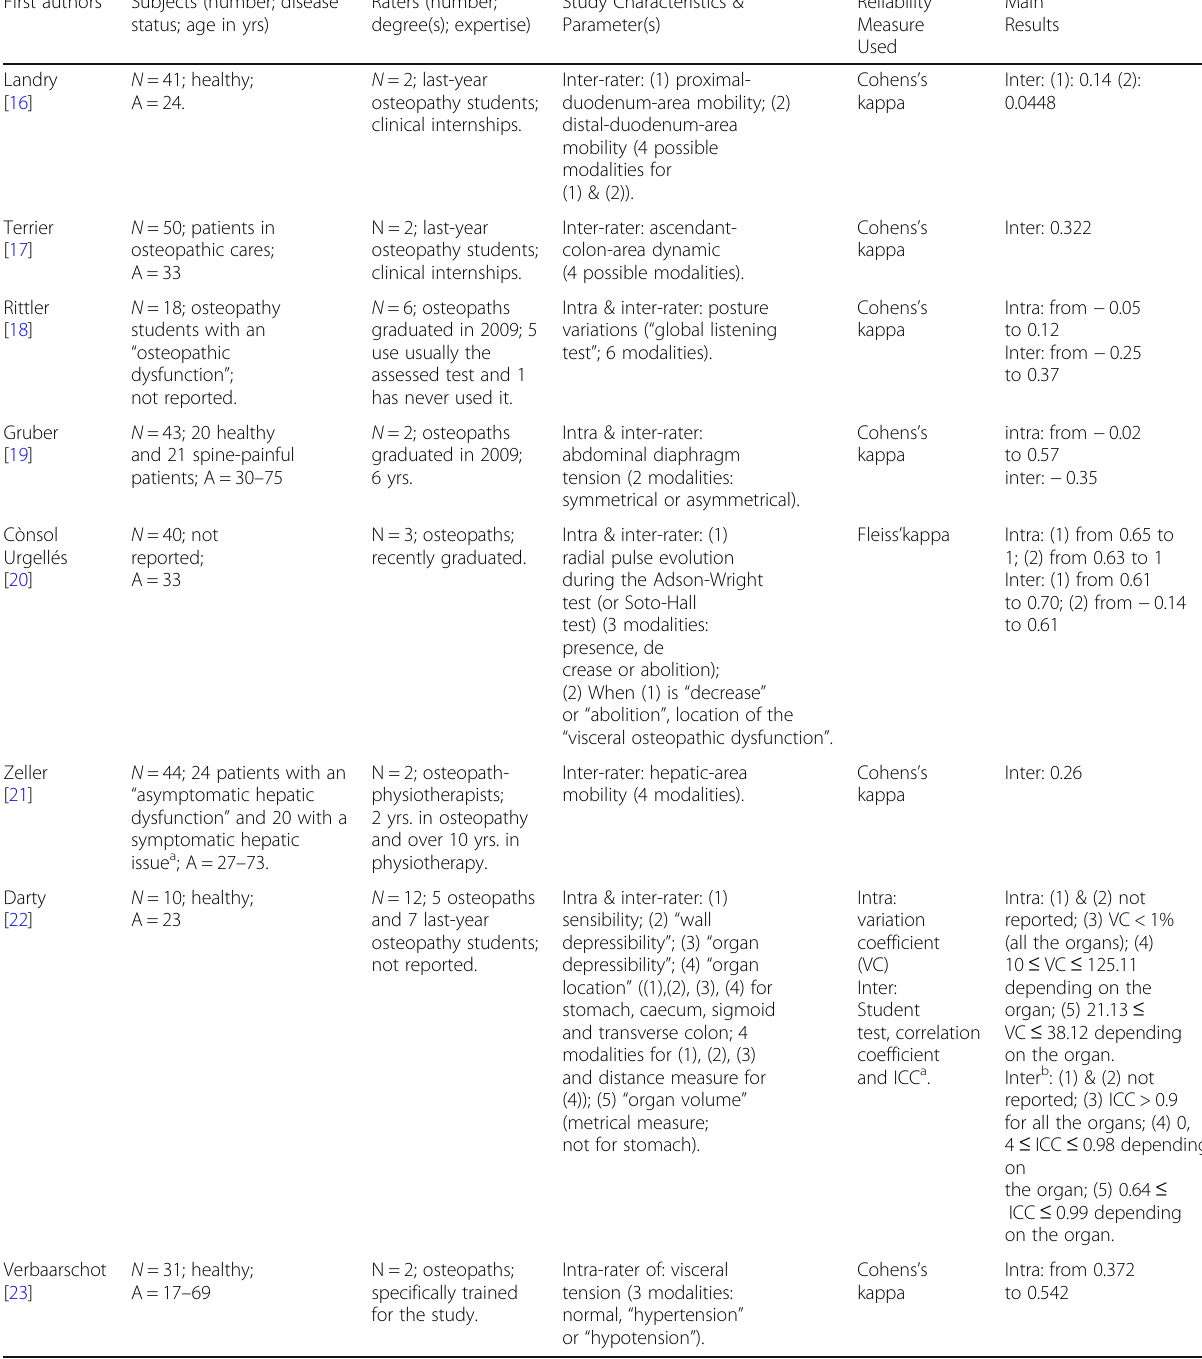
Table 1 Summary of included studies dealing with the reliability of diagnosis in visceral